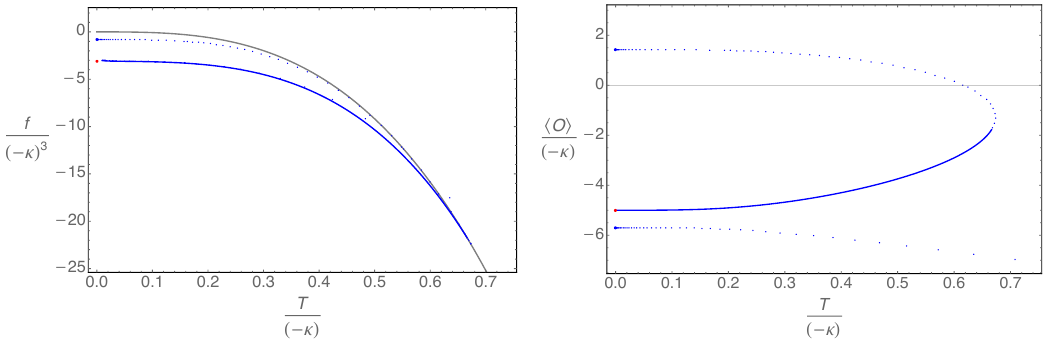
Figure 5 . Left: the free energy of the black hole solutions with λ 3 = 1 / 8 and λ 4 = 1 / 10 . The grey line is for Schwarzschild solution and the other lines are for hairy black hole solutions. Right: the VEV h O i as a function of T/ ( − κ ) . In both plots, the solid blue line is for stable hairy black hole solution while the dotted blue lines are for unstable hairy black hole